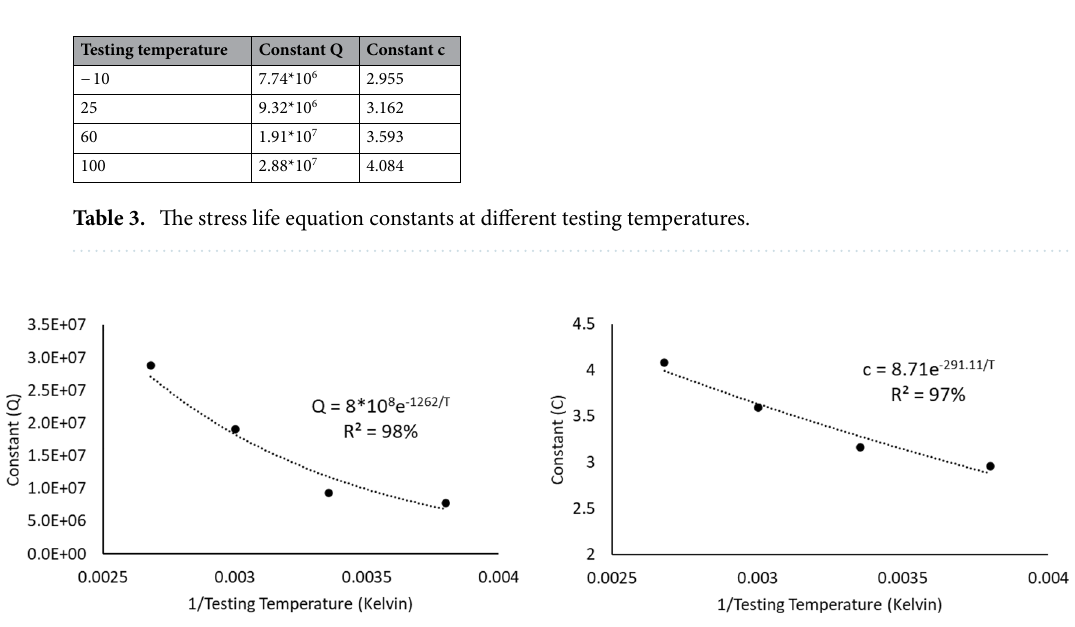
Figure 8. Modeling the evolutions in the stress life equation constants using the Arrhenius